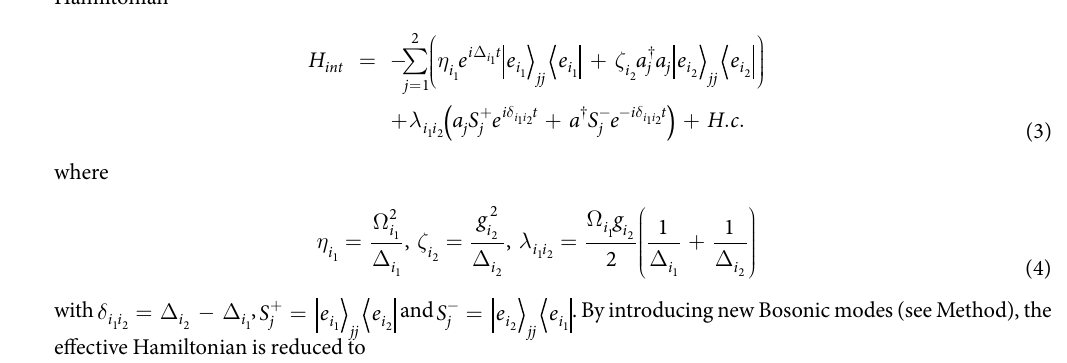
, d 1 ↔ e r of each atom is driven by a classical laser field with Rabi i 2 frequency Ω , while the transition ↔ e r is driven by the cavity mode with coupling constant g i 1 i 1 number of the fiber is on the order of ν π l c /2 , where l is the length of the fiber and ν is the decay rate of the cavity field. When ν π ≤ l c /2 1 , there is only one fiber mode which essentially interacts with the cavity modes and the cavity-fiber coupling is described by the Hamiltonian as follows 29, 30